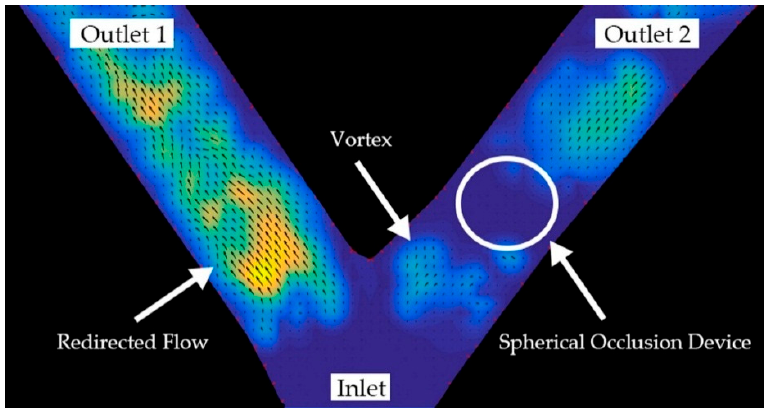
Figure 12. Digital particle image velocimetry (DPIV) image showing successful occlusion performance.